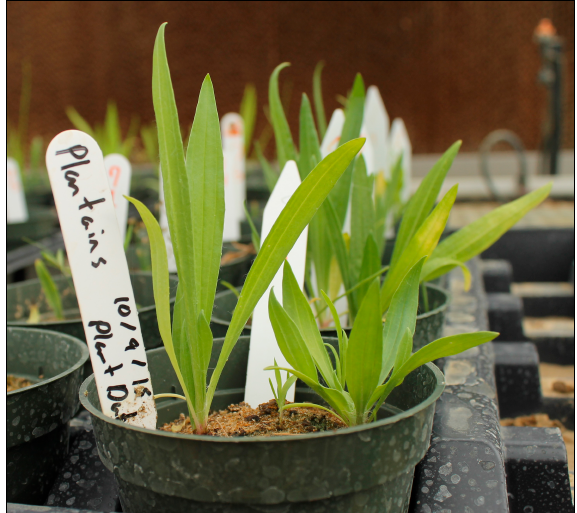
Figure 3. Plantago lanceolata L. plants tested in greenhouse experiments for response to herbicides (photograph by Sidney Cromer, used with permission).